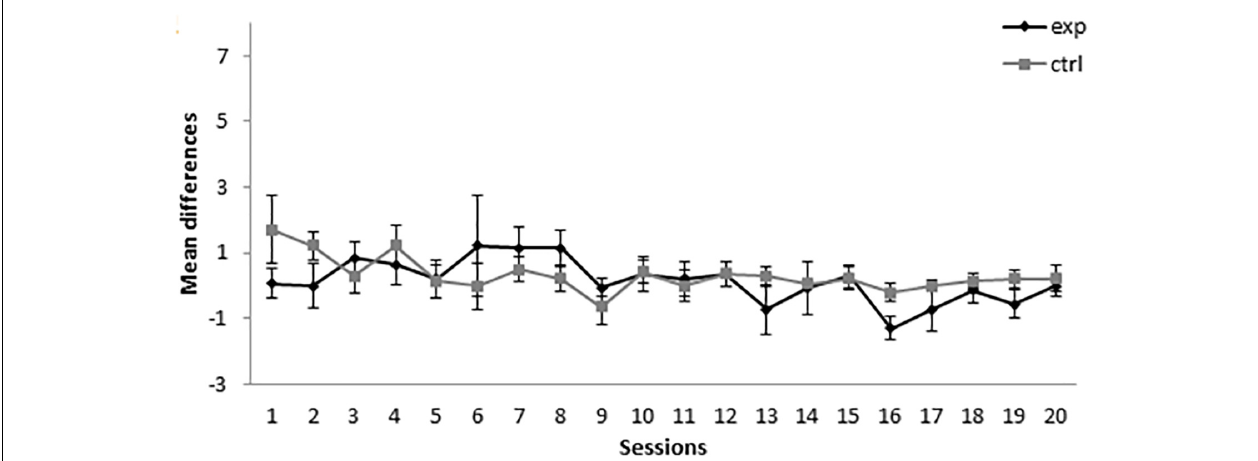
FIGURE 5 | Conditioning phase in Experiment 3. PreX-X differences ( ± SEM), averaged for the two X – presentations per session in conditioning, are displayed. The black line represents the group that was trained with five A+, 11 AX – , three F – , nine F+, and two X – presentations per session in conditioning. The gray line represents the group that was trained with five A+, 11 BX – , three F – , nine F+, and two X – presentations per